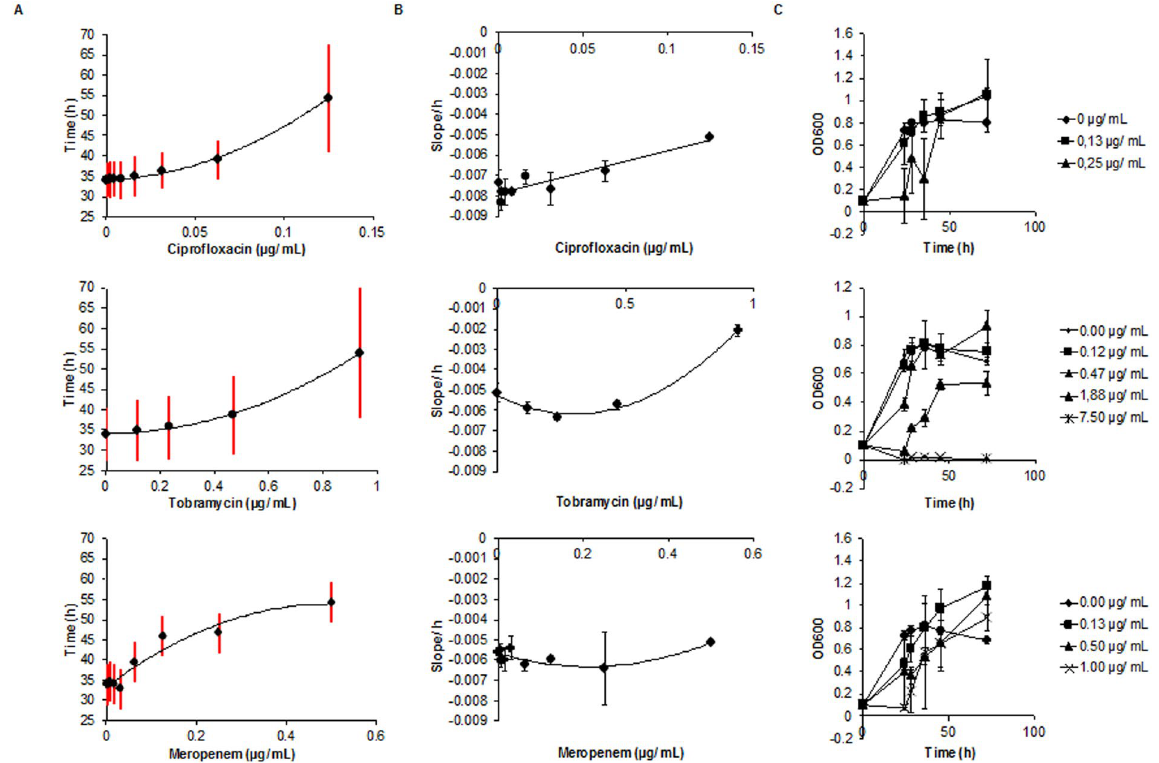
Figure 5. Impact of ciprofloxacin, tobramycin, and meropenem on biofilm formation of the PA14 wt strain over 70 h. ( A ) Impact of antibiotics on the time period of biofilm formation. The red vertical bars cover the time period of linear decline of the cell index value at a given antibiotic concentration, as determined by the fitting model. The lower end of the red bar marks the onset of CI decline, the upper end marks the end of the decline (n = 3 or 4). ( B ) The slope of the cell index is plotted against the antibiotic concentration (n = 3 or 4). ( C ) Growth curves of PA14 at various antibiotic concentrations over time (n = 4). The starting OD600 at t = 0 was 0.1. n indicates the number of technical